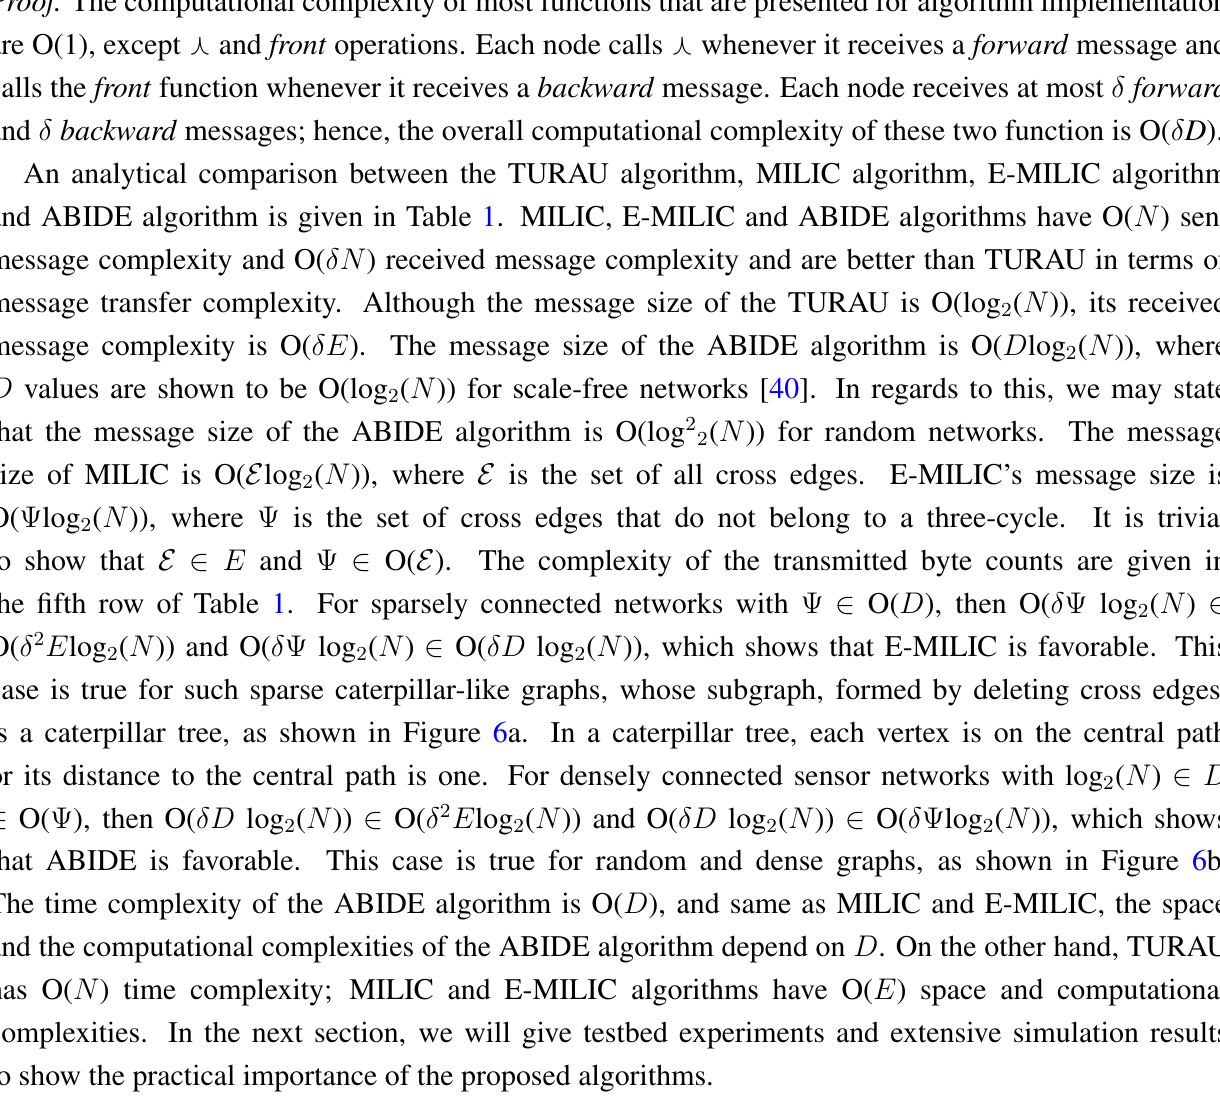
Table 1. Analytical comparison of